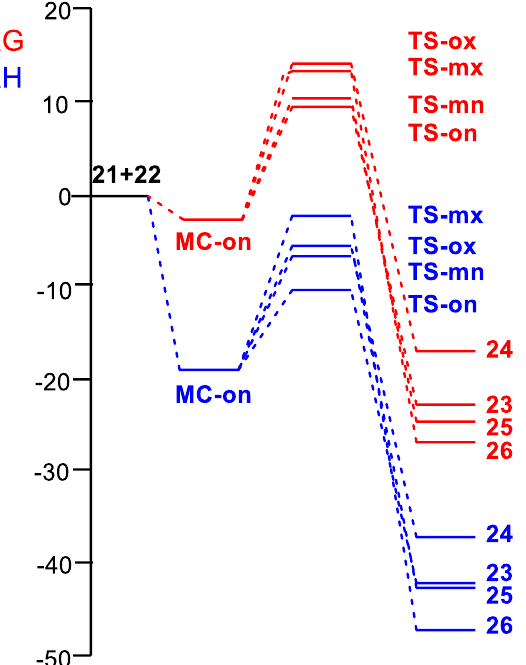
Figure 3. ω B97X-D/6-311G(d,p) enthalpy ∆ H in kcal mol –1 (blue) and Gibbs free energy ∆ G in kcal mol –1 (red) profiles, at 65 ◦ C in methanol, for the 32CA reaction of AY 21 with ferrocene ethylene 22 .